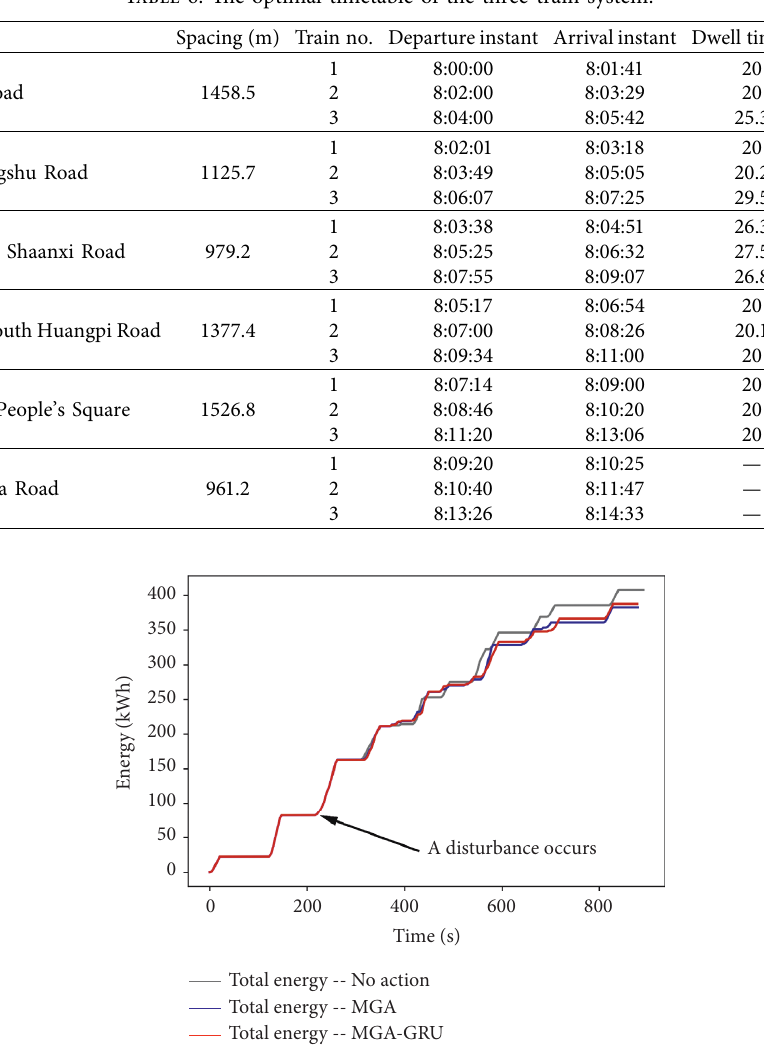
Figure 9: Changes in net energy consumption with different strategies under the − 2.37s dwell